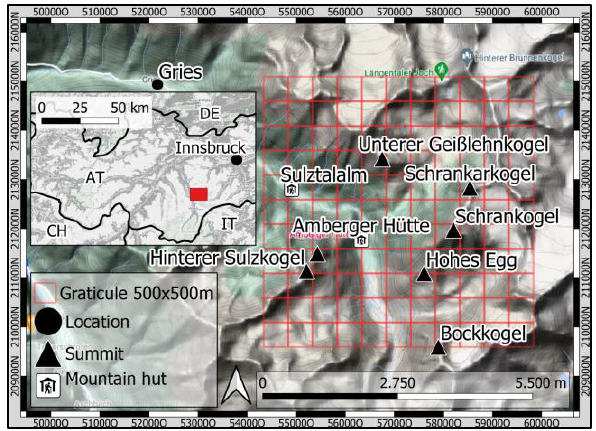
Figure 1 . Study site with processing units (graticule